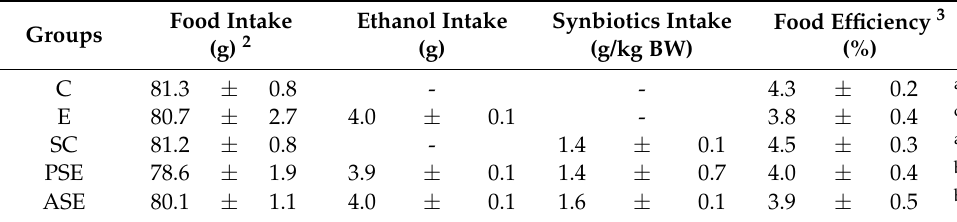
Table 1. Effects of synbiotics supplementation on the intake of food, ethanol and synbiotics in rats with chronic ethanol feeding 1 .